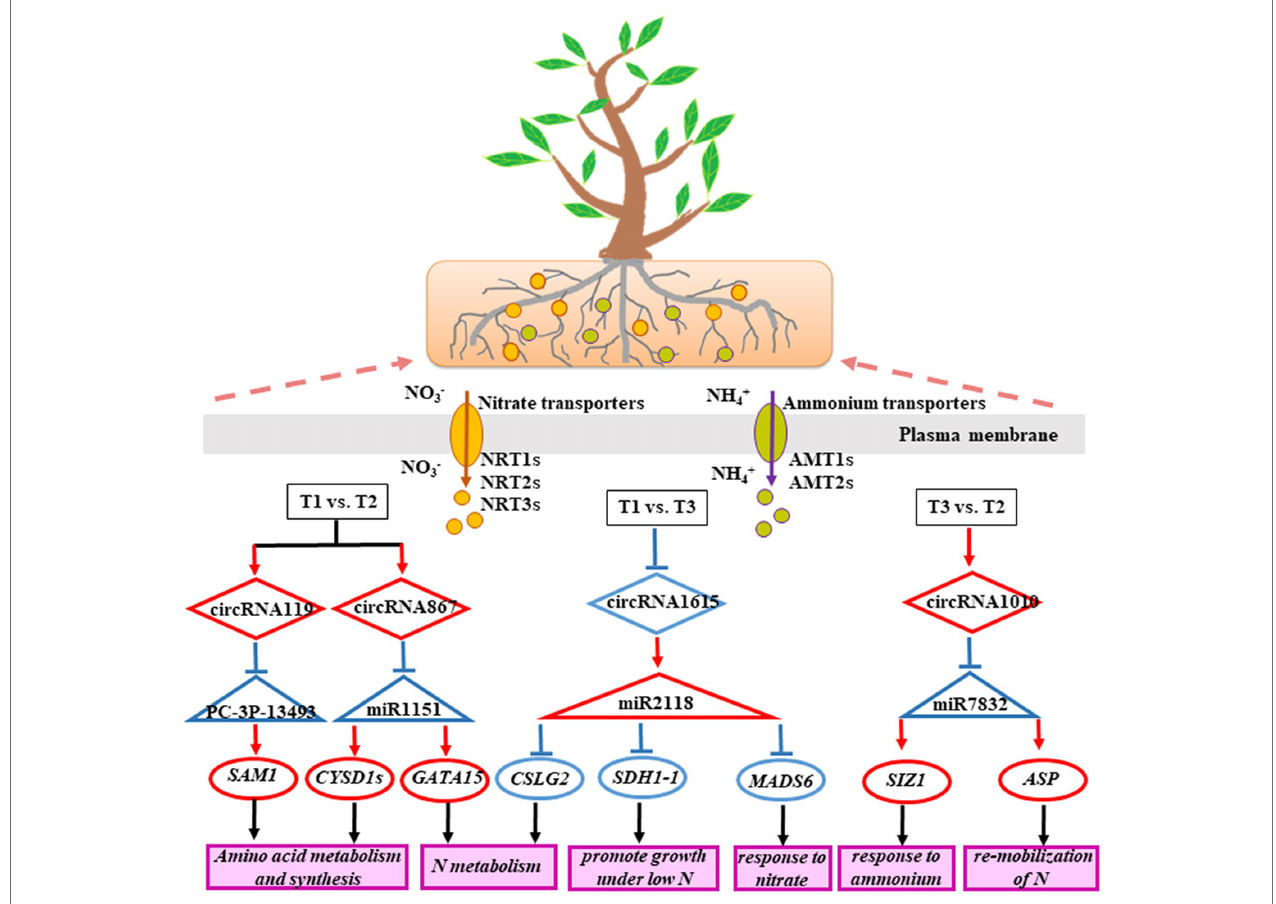
FIGURE 6 | A schematic model of the ceRNA regulatory network involved in the P. × canescens root response to different N